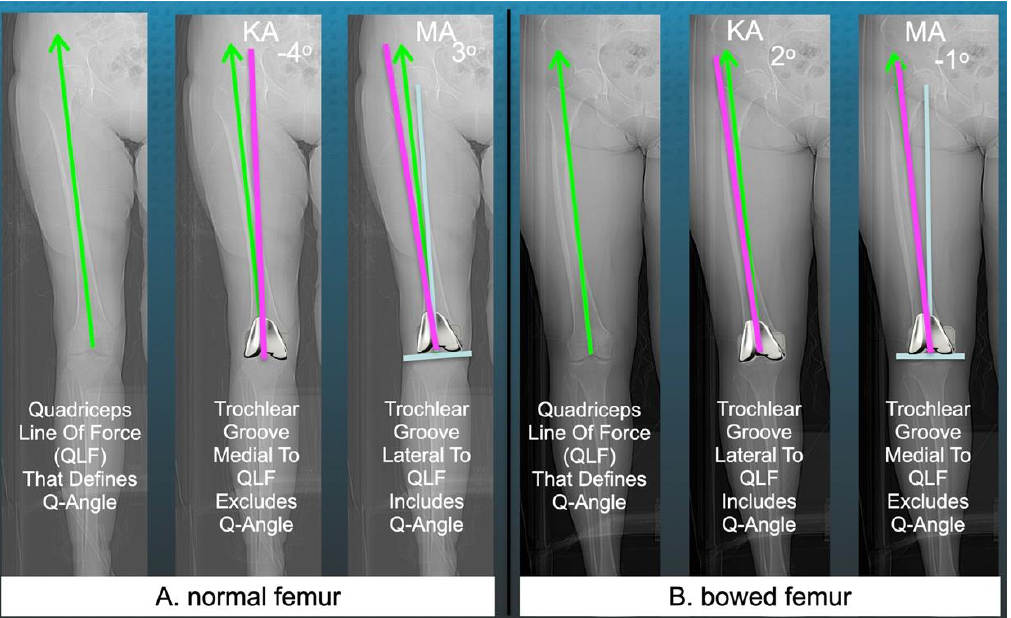
Figure 2. Radiographs of two femurs with a straight diaphysis ( A ) and a lateral bow ( B ) with a femoral component placed with kinematic alignment (KA) and mechanical alignment (MA) showing the new method for measuring the angle between the femoral component’s trochlear groove orientation (magenta line) and the quadriceps line of force (green line) that connects the anterior inferior iliac spine (AIIS) to the center of the knee and comprises the patient’s Q-angle. For MA, the femoral component is placed orthogonal to the femoral mechanical axis (blue line).